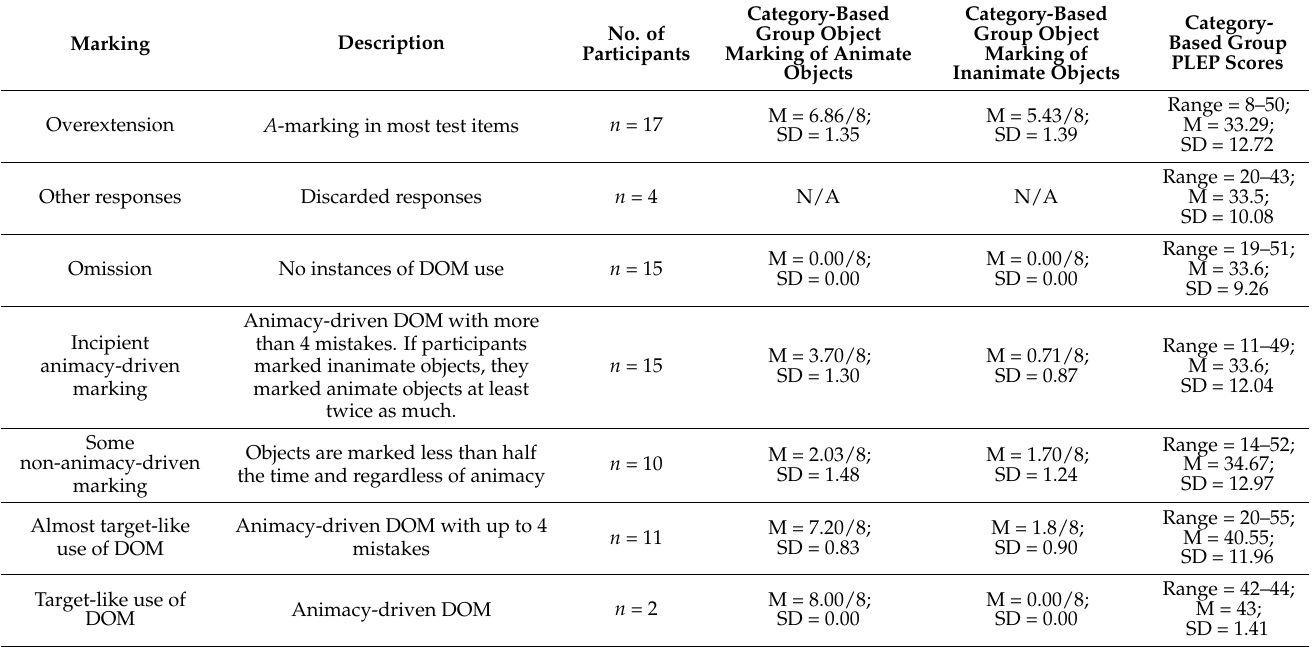
Table 5. Types of marking in the Spanish EPT in increasing average PLEP score